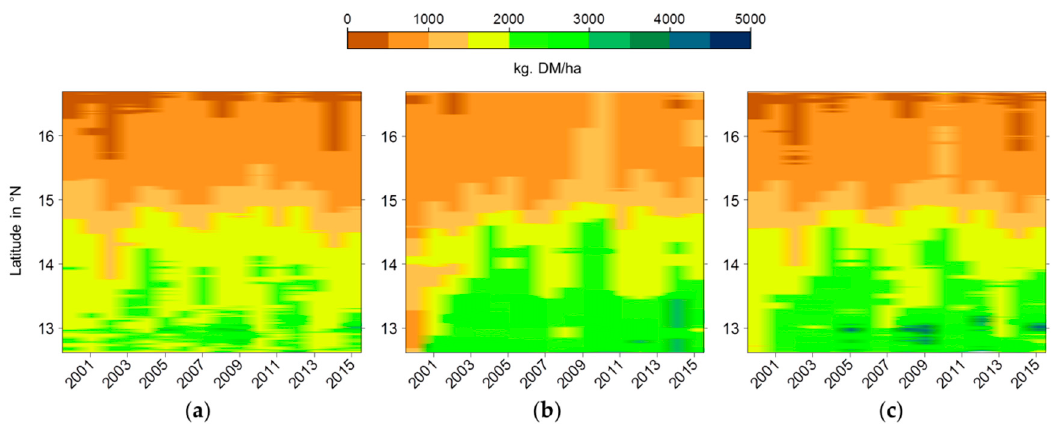
Figure 7. Latitudinal variation of the herbaceous yield estimated by the: ( a ) VI-model; ( b ) AGRO-model; ( c ) VIAGRO-model during the 2000–2015 period.